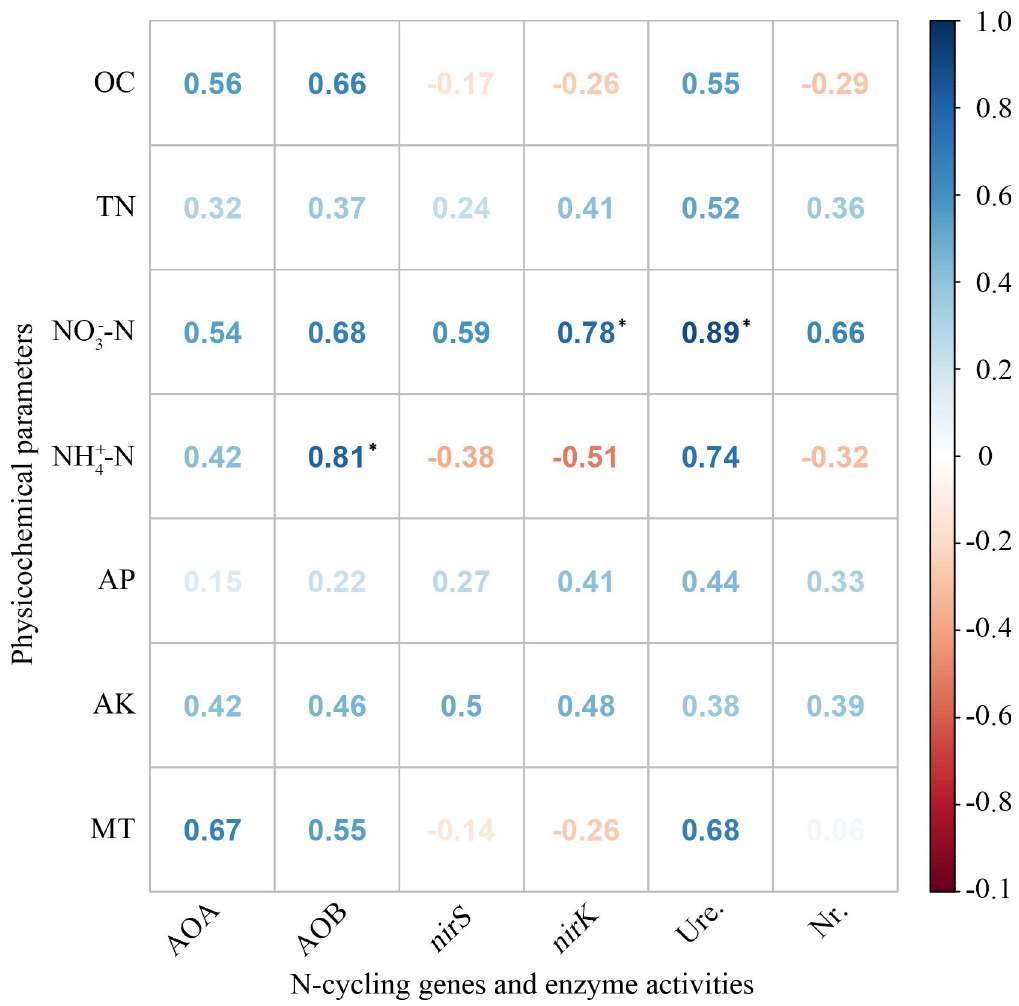
Fig 4. Correlation analysis between N-cycling genes, enzyme activities and physicochemical parameters in the soil. OC, organic C; TN, total N; AP and AK, available P and K; MT, moisture; AOA, amoA AOA; AOB, amoA AOB; Ure., urease activity; Nr., nitrate reductase activity. � represents significant correlation ( p <